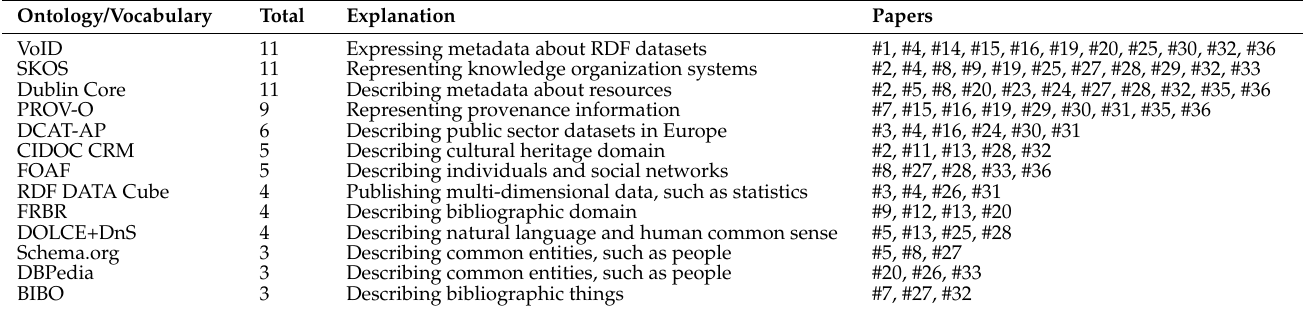
Table 5. Most used ontologies and